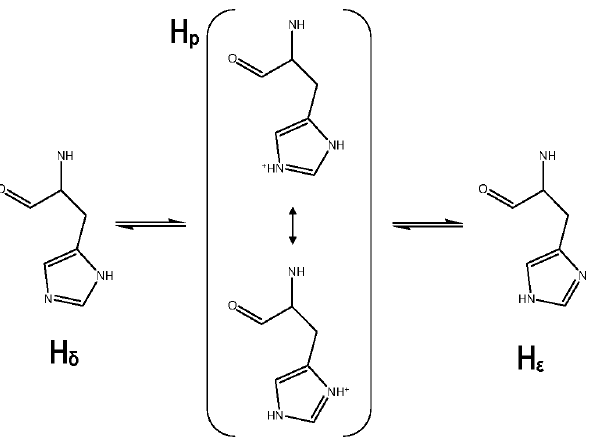
Figure 1. Protonation states of the